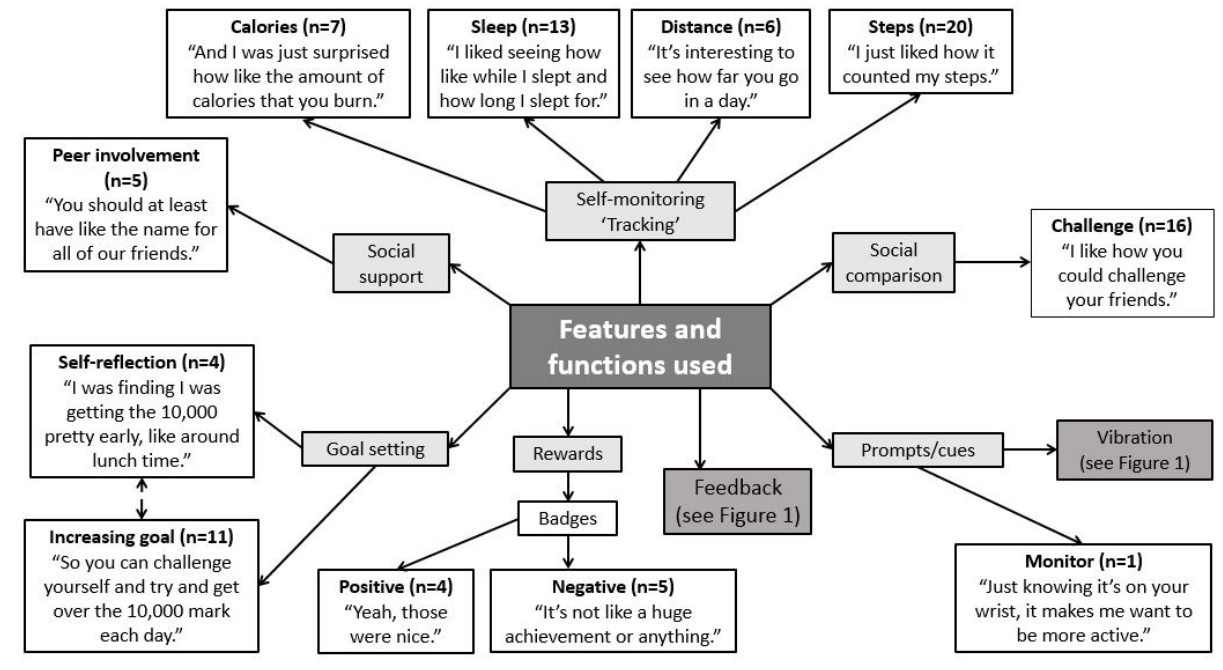
Figure 2. Features and functions of the Fitbit used by the adolescents.